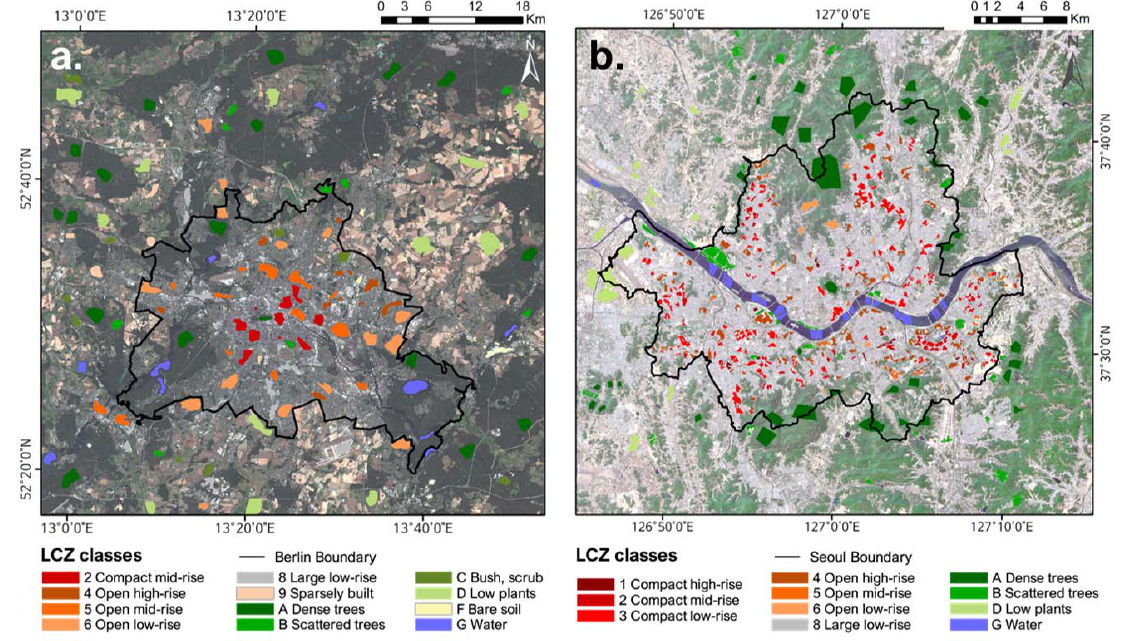
Figure 2. Study areas of Berlin ( a ) and Seoul ( b ) with the local climate zone (LCZ) reference data.